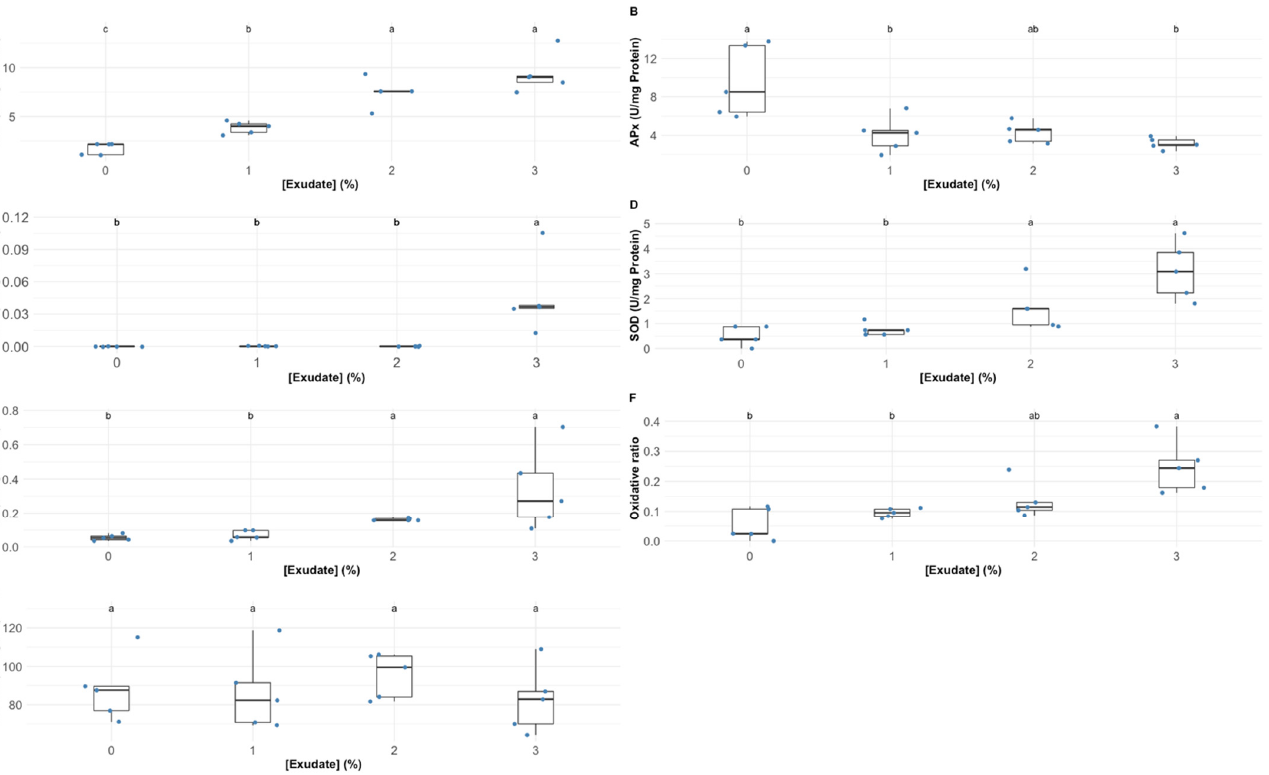
Figure 6. Thellungiella halophila leaf oxidative stress biomarkers (CAT—catalase activity ( A ); SOD—superoxide dismutase activity ( B ); GR—glutathione reductase activity ( C ); APx—ascorbate peroxidase activity ( D ); GPx—guaiacol peroxidase activity ( E ); oxidative ratio ( F ); and TBARS—thiobarbituric acid reactive substances (MDA equivalents) ( G )) in the plants exposed to Asparagopsis armata exudate at the proposed target concentrations at the end of the trial period (N = 5 per treatment; letters denote significant differences between treatments at p < 0.05).